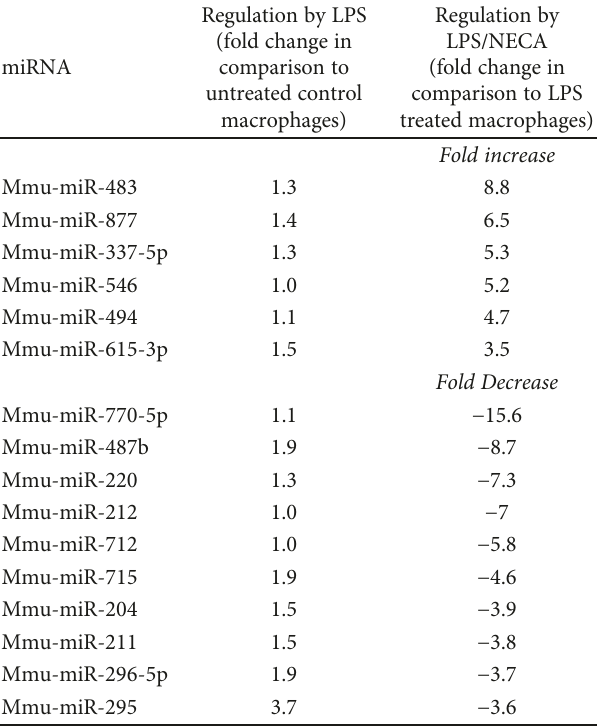
Table 1: MiRNAs di ff erentially regulated in murine peritoneal macrophage by LPS (M1 activation) versus LPS/NECA